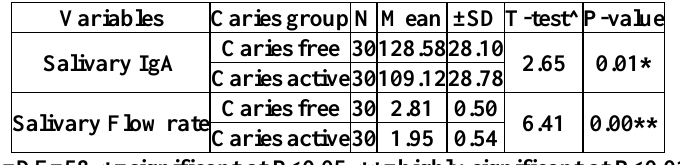
Table 3: Comparison for total sample ofsalivary IgA mg/dl, salivary flow rate ml/min